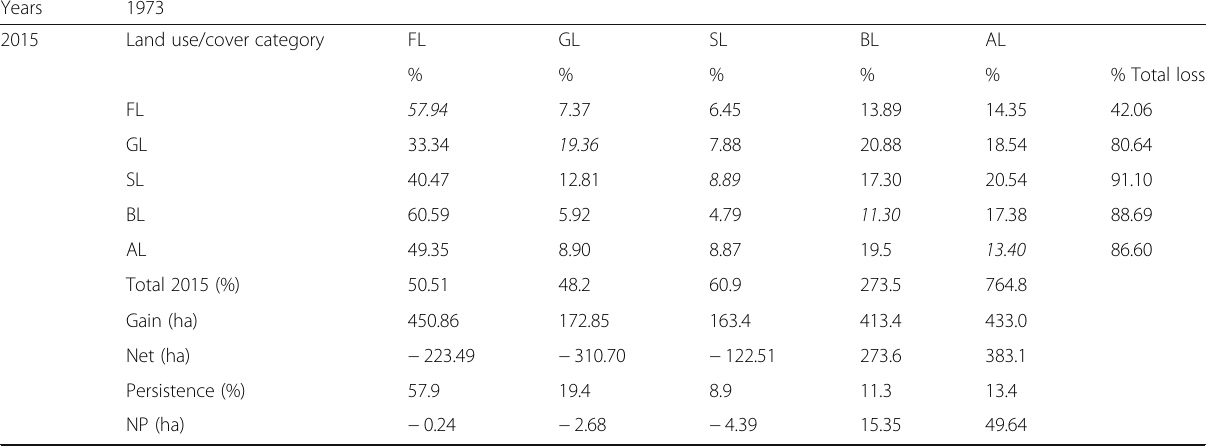
Table 3 Land use/cover change matrix showing land encroachment (in %) in the study area, Sidama, South Ethiopia between 1973